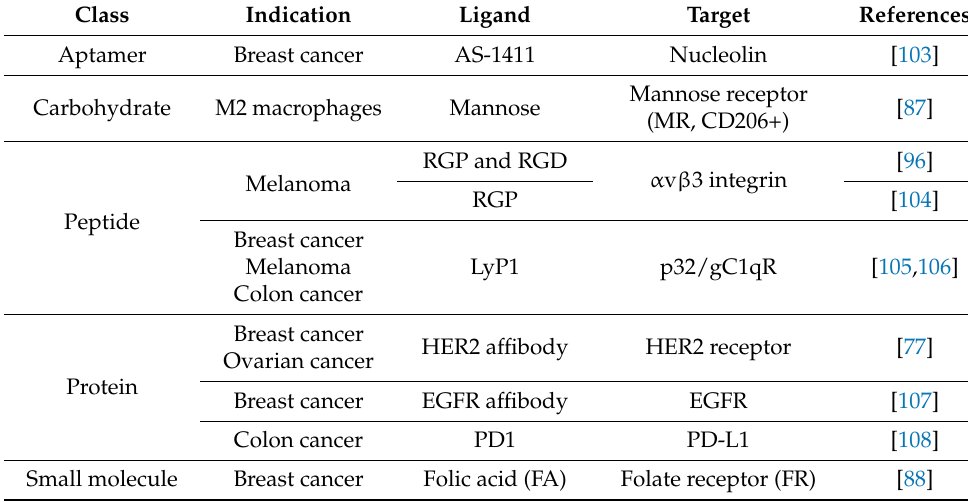
Table 2. Ligands used for active targeting of BMVs in cancer